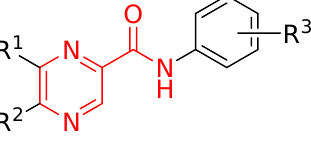
Figure 1. Pyrazinamide structure modification (see the pyrazinamide fragment, red